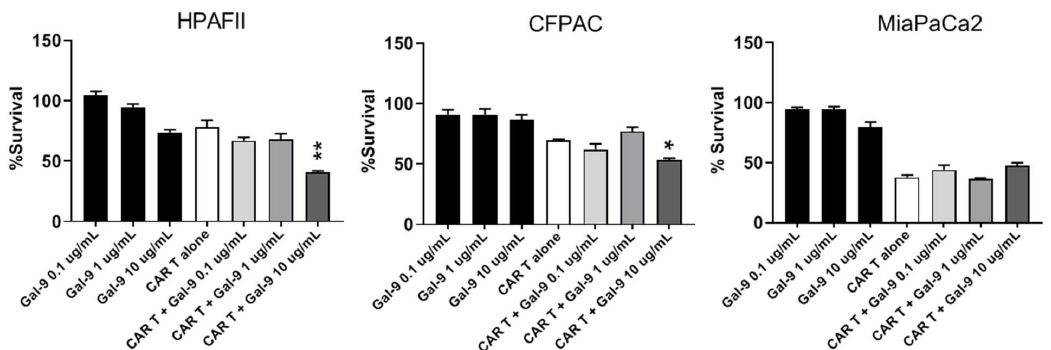
Figure 7. Targeting resistance related genes with anti-Gal-9 blocking Ab. Percentage survival of HPAFII, CFPAC, and MiaPaCa2 cells after treatment with CAR T alone, Gal-9 blocking Ab alone, and combination of CAR T cell and Gal-9 blocking Ab. Anti-Gal-9 Ab was added at three different concentrations to the co-culture media of PDA cells and mock or CAR T cells (T:E 1:10). Percentage survival was obtained using MTT assay and data was normalized to mock T. HPAFII and CFPAC survival were reduced with combination of CAR T and anti-Gal-9 blocking Ab; while MiaPaCa2 did not respond to the combination therapy. Student’s t-test comparing CAR T + anti-Gal-9 Ab group to CAR T alone group. * p < 0.05, ** p < 0.01. Error bars, SEM. n = 4.